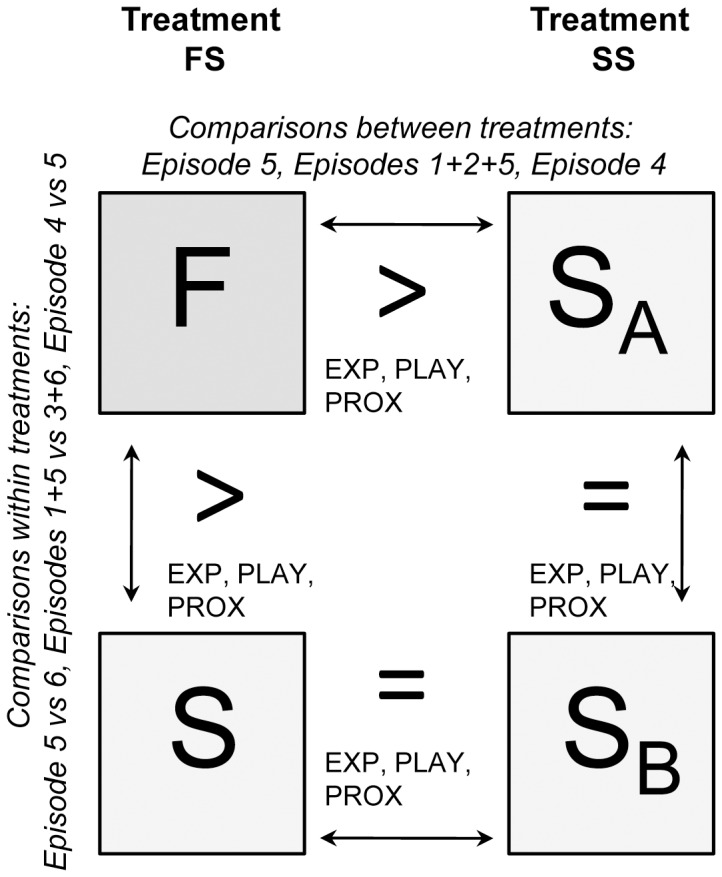
A schematic representation of predictions.Closed boxes refer to episodes where either F (familiar person) or S (stranger) was present in the room in the FS (familiar stranger) treatment or SA (stranger A) or SB (stranger B) was present in the room in the SS (stranger stranger) treatment. The arrows indicate the comparisons that were made. According to our hypothesis, if the ASSP is a reliable method to use when assessing the bond between dogs and humans, dogs should explore (EXP) and play (PLAY) more in the presence of the familiar person and they should show more proximity seeking behaviours (PROX) towards the familiar person.